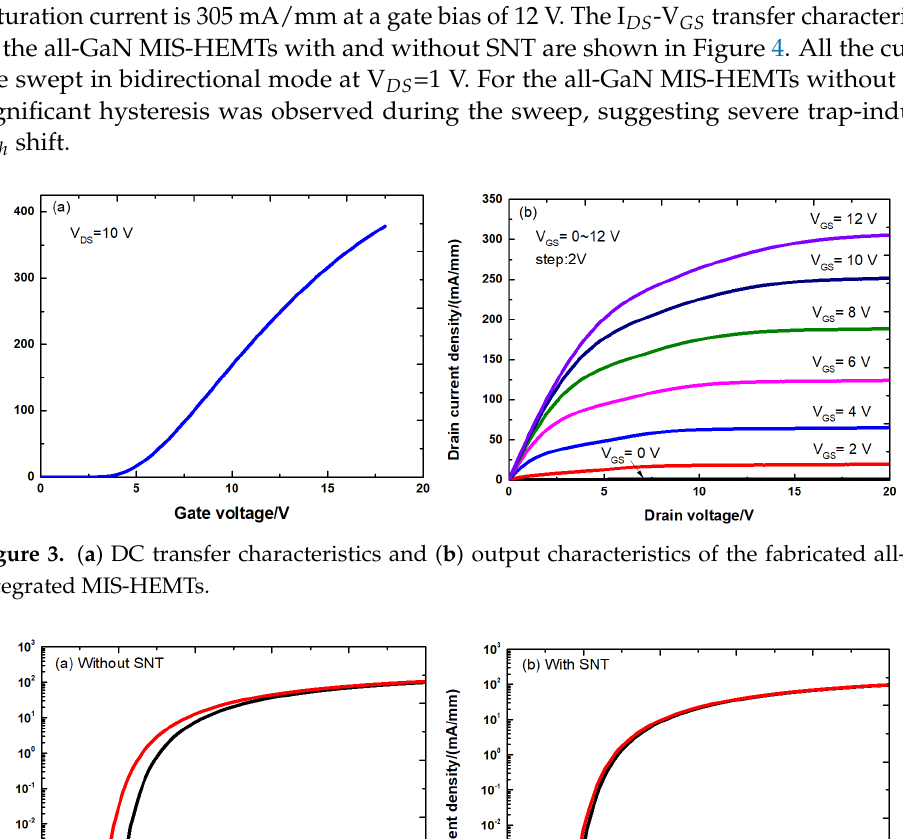
from 0 V to s weep